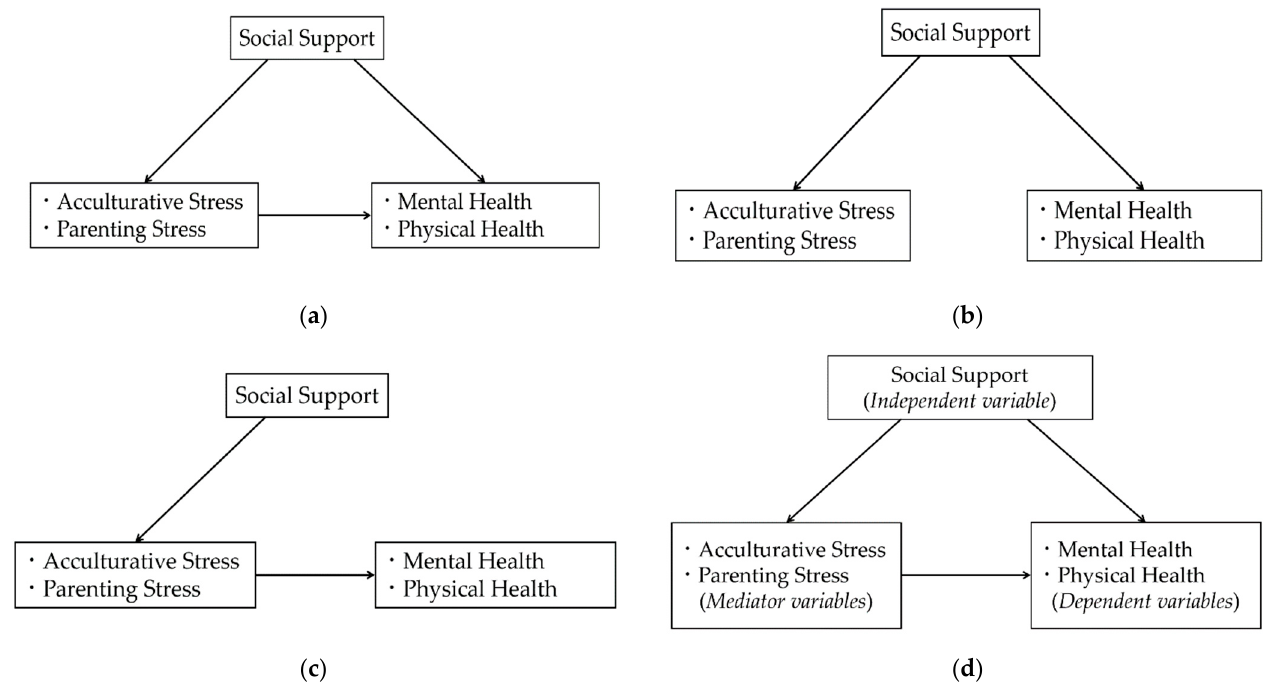
Figure 1. ( a ) Theoretical framework of the relationships among social support, acculturative stress, parenting stress, mental health, and physical health; ( b ) Hypothesis 1: direct effect among main variables; ( c ) Hypothesis 2: indirect effect among main variables; ( d ) Hypothesis 3: the mediating effect of stress between social support and health.